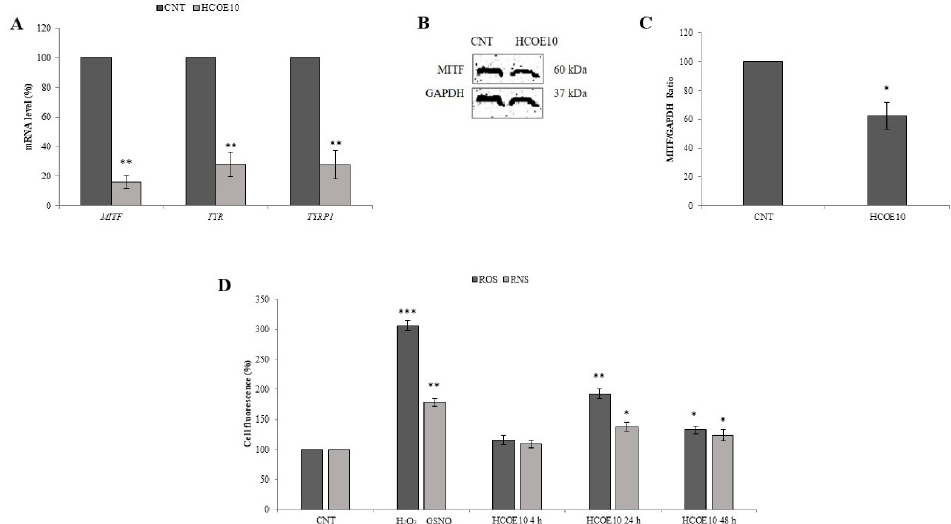
Figure 3. Analysis of mouse monoclonal microphthalmia-associated transcription factor (MITF) signaling and cell redox state. ( A ) MITF , tyrosinase ( TYR ) , and tyrosinase-related protein 1 ( TYRP1 ) mRNA levels, measured by RT-PCR, in A375 cells treated for 48 h with 10 mg / mL HCOE are reported. Gene expression calculated as mRNA amount after normalization for β -actin (ACTB) mRNA (2 - ∆∆ Ct ) is reported as percentage with respect to the PBS control (considered as unit, 100%). Data represent the mean ± SD of four independent measurements (** p < 0.01 vs. control). ( B ) Representative Western blotting membrane of Mitf and Gapdh protein levels is shown. ( C ) Quantitation of MITF protein in A375 cells treated for 48 h with HCOE 10 mg/mL is reported. The results obtained by the ratio between Mitf and Gapdh (used as internal loading control) are indicated as percentage values with respect to PBS control (considered as unit, 100%). Data indicate the mean ± SD of three independent experiments (* p < 0.05 vs. control). ( D ) Intracellular reactive oxygen (ROS) and nitrogen (RNS) species levels were quantified in A375 cells, treated with 10 mg / mL of HCOE for 4, 24, and 48 h, by DCFH-DA and DAF-FM DA fluorescent assays, respectively. Radical species concentration is reported as percentage compared to PBS control (CNT). Hydrogen peroxide (H 2 O 2 ) and S-Nitrosoglutathione (GSNO) treatments were performed as positive controls for ROS and RNS analysis, respectively. Results are expressed as mean ± SD of three independent measurements (* p < 0.05; ** p < 0.01; *** p < 0.001 vs. control).